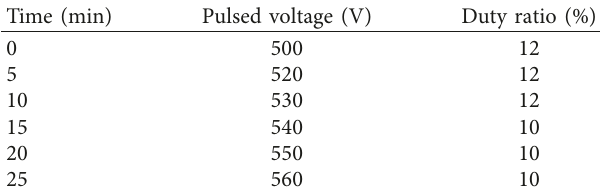
Table 1: Electrical parameters of the treatment